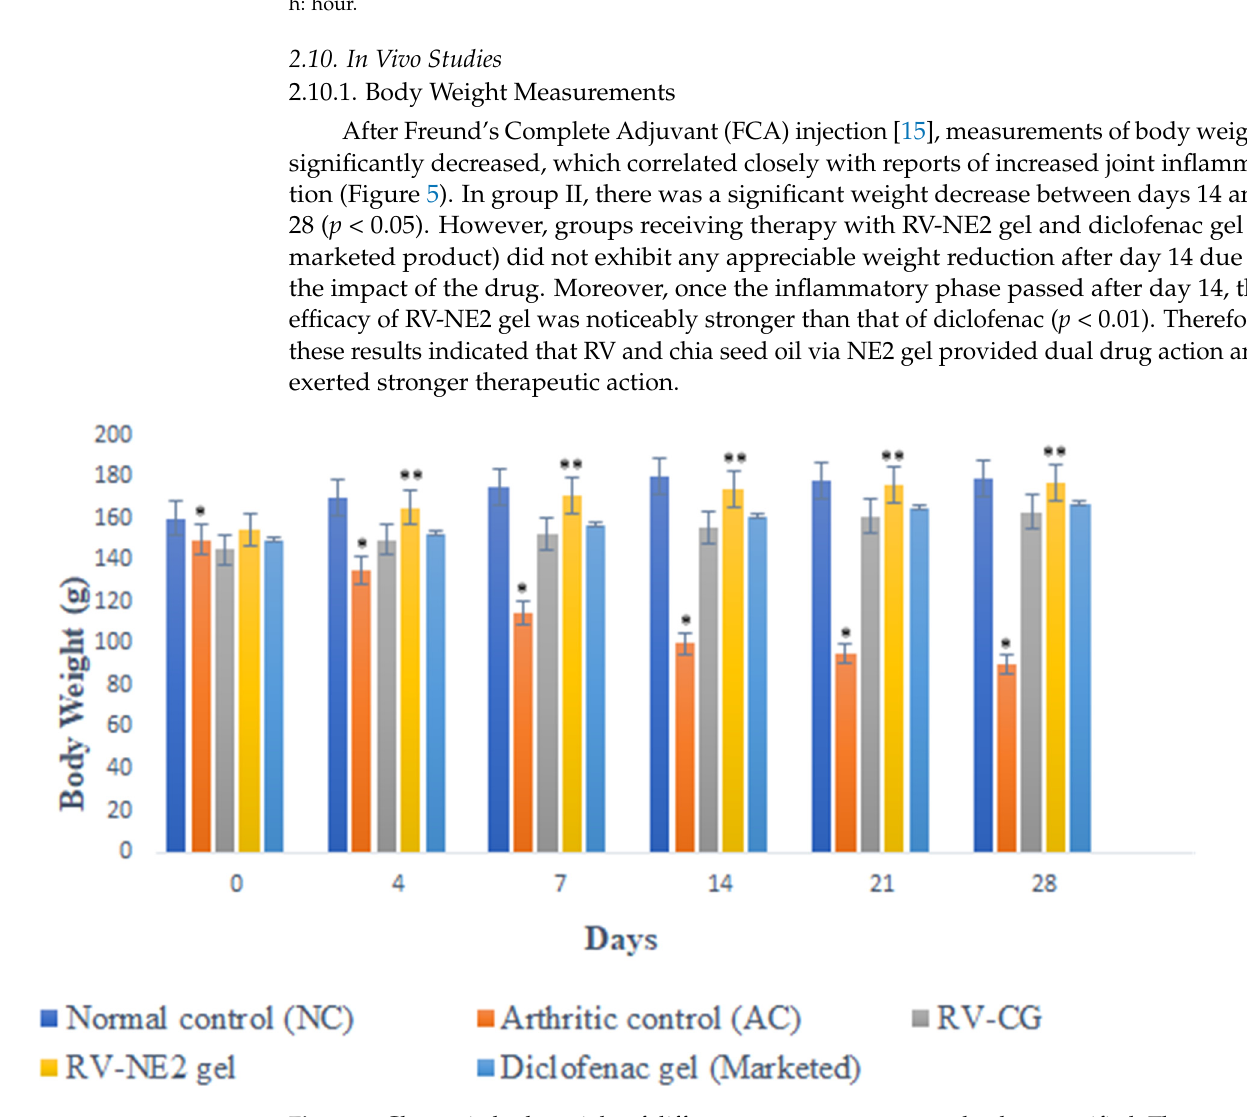
Figure 5. Change in body weight of different treatment groups on the days specified. The average value ± SD ( n = 3) is represented by each cross bar. NC = normal control, AC = arthritic control, RV = resveratrol, CG = conventional gel. The comparisons were made by ANOVA followed by Tukey's test. * p < 0.05 and ** p < 0.01 were considered significant.